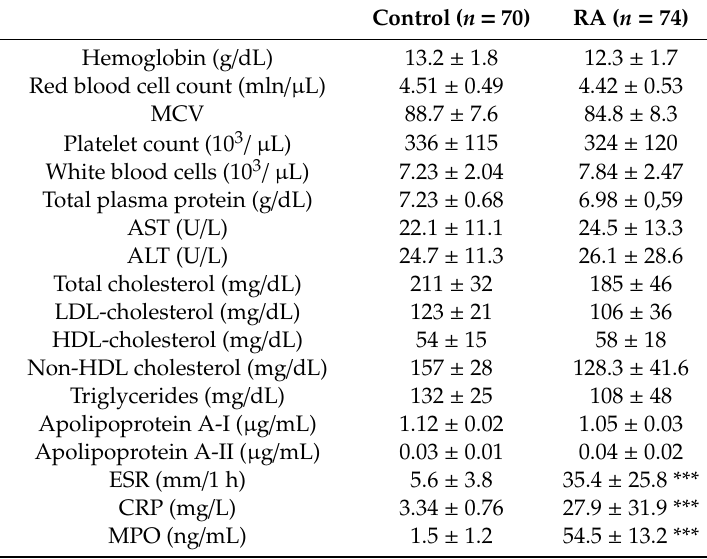
Table 2. Laboratory data of RA patients and control